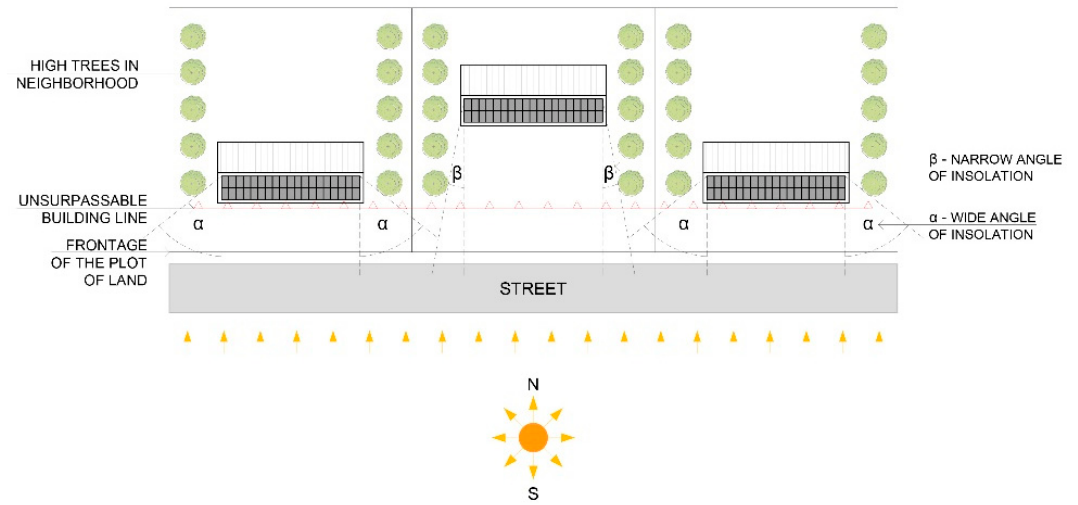
Figure 6. Probable positions of buildings and PV panels because of noncompulsory unsurpassable building line defined in the zoning plan (diagram by W. Celadyn, P. Filipek).